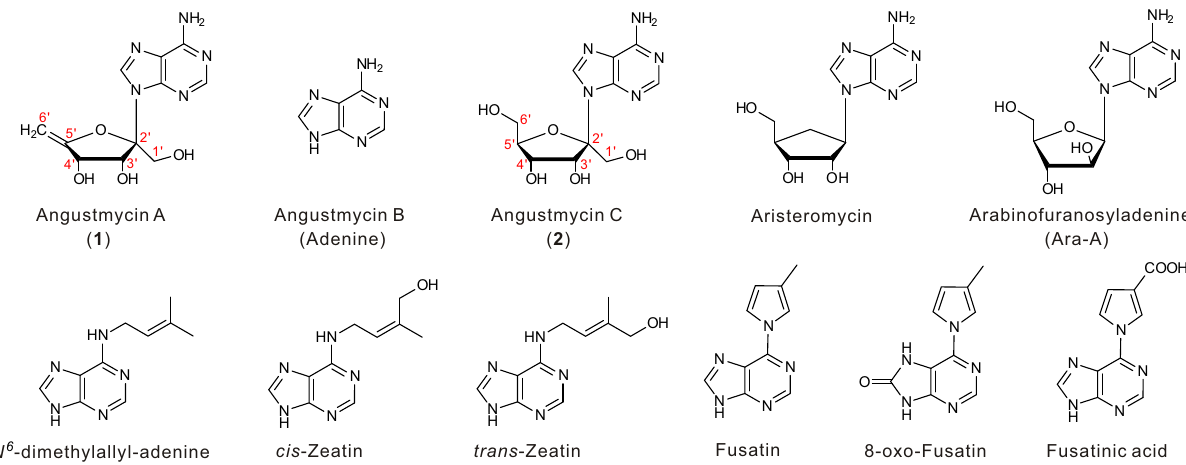
Fig. 1 Chemical structures of angustmycin-related purine nucleoside antibiotics and cytokinins. Relevant purine nucleosides (top) include three components of angustmycins and their analogs aristeromycin and Ara-A; purine nucleoside cytokinins (bottom) contain structural moieties similar to the purine